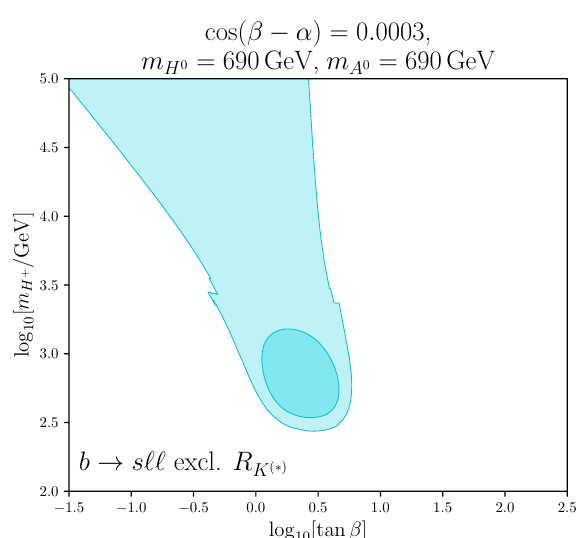
Figure 14. Contour plot of the allowed 2HDM-II parameter space in the (tan β − m the leptonic B d,s → µ + µ − decays and the semi-leptonic b → s‘ + ‘ − observables listed in table 7 excluding the R observables and fixing the additional parameters to the best fit point from the K ( ∗ ) b → s‘ + ‘ − fit in table 2. The lighter contour indicates the allowed parameter space at 2 σ confidence level while the darker contour corresponds to 1 σ